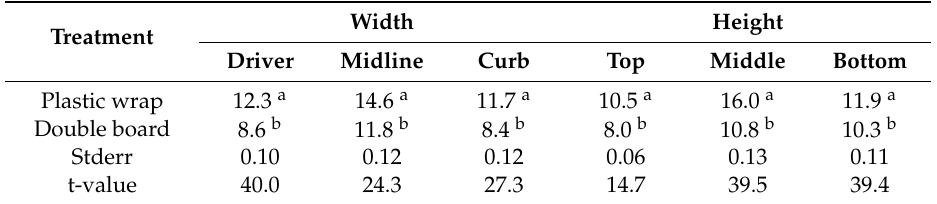
Table 9. Means and standard errors of elevated temperatures above ambient ( ∆ t, ◦ C and the paired sample t-test at various locations of paired trailers with either plastic wrap or double board on two winter nights with average ambient temperatures of − 5 and − 17 ◦ C,